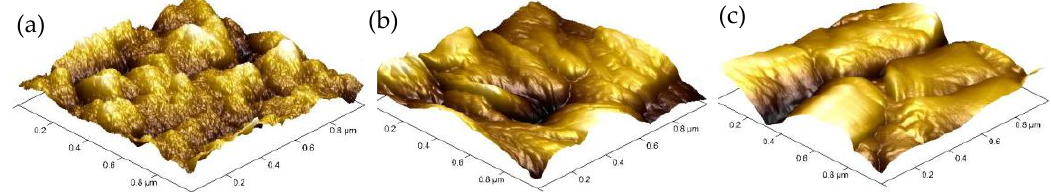
Figure 3. AFM images of GO films covering ITO glass with GO concentrations of ( a ) 0.05 ωt%, ( b ) 0.5 ωt%, and ( c ) 2 ωt% in the GO layers.